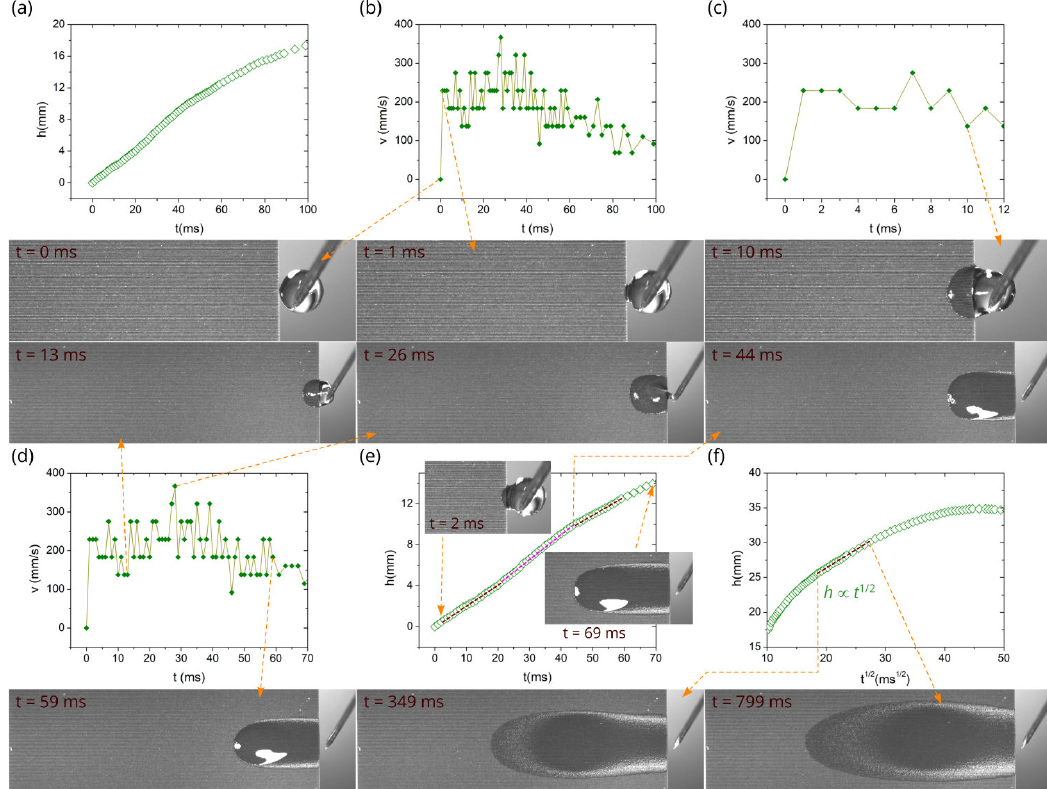
Figure 6. Detailed h ( t ) and v ( t ) plots along with snapshots of water spreading at 80 ◦ C. ( a ) Plot of the spreading distance as a function of time between 0 and 100 ms. ( b ) Plot of the velocity as a function of time between 0 and 100 ms. ( c ) Plot of the velocity as a function of time between 0 and 12 ms. ( d ) Plot of velocity as a function of time between 0 and 70 ms. ( e ) Detailed plot of the spreading distance as a function of time between 0 and 70 ms. ( f ) Plot of the spreading distance as a function of t 1 / 2